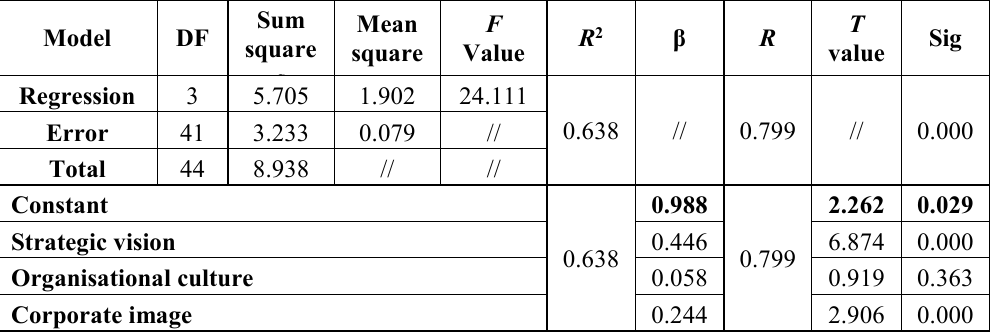
Source: made by the researchers on the basis of the SPSS